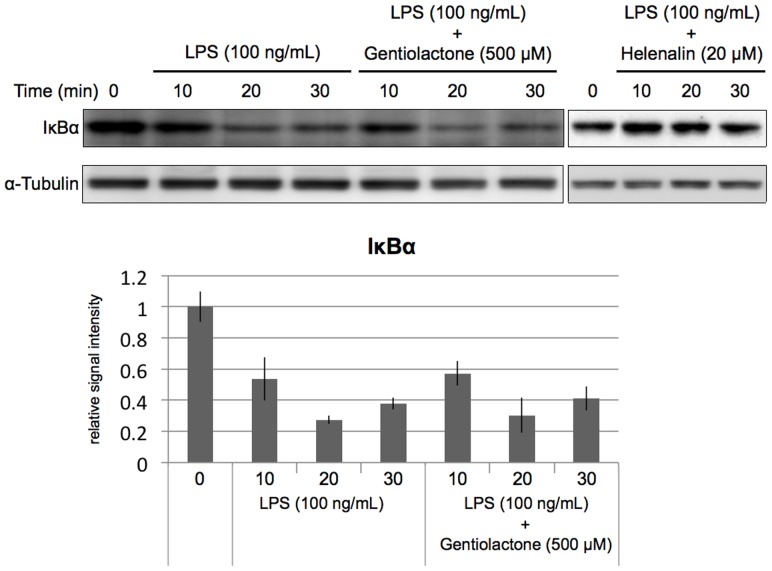
Gentiolactone does not inhibit IκB degradation induced by LPS stimulation.RAW264.7 cells were cultured with LPS (100 ng/mL) and gentiolactone (500 µM) for the indicated periods. Cell extracts from each group were examined by immunoblotting analysis using anti-IκBα antibody. Plotted values represent the mean value ± SD from four independent cultures. Helenalin was used as a positive control.